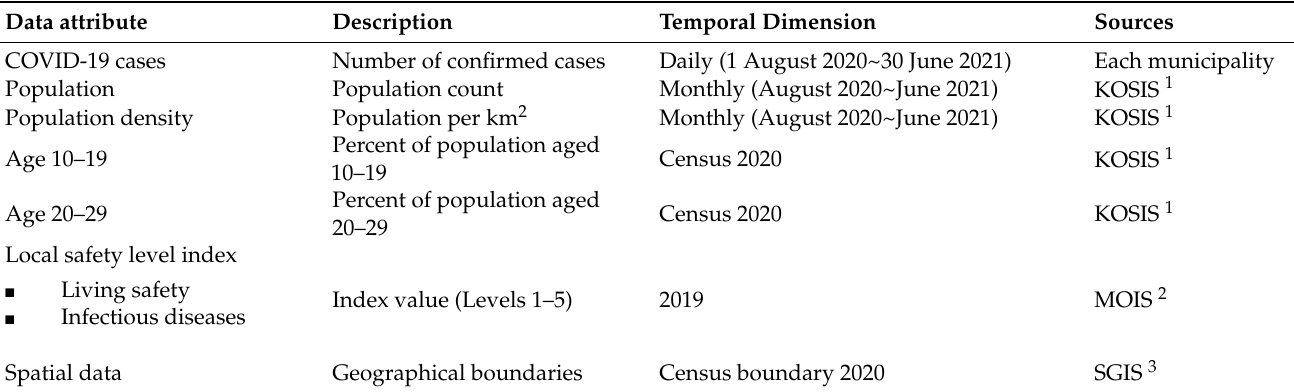
Table 1. Data in